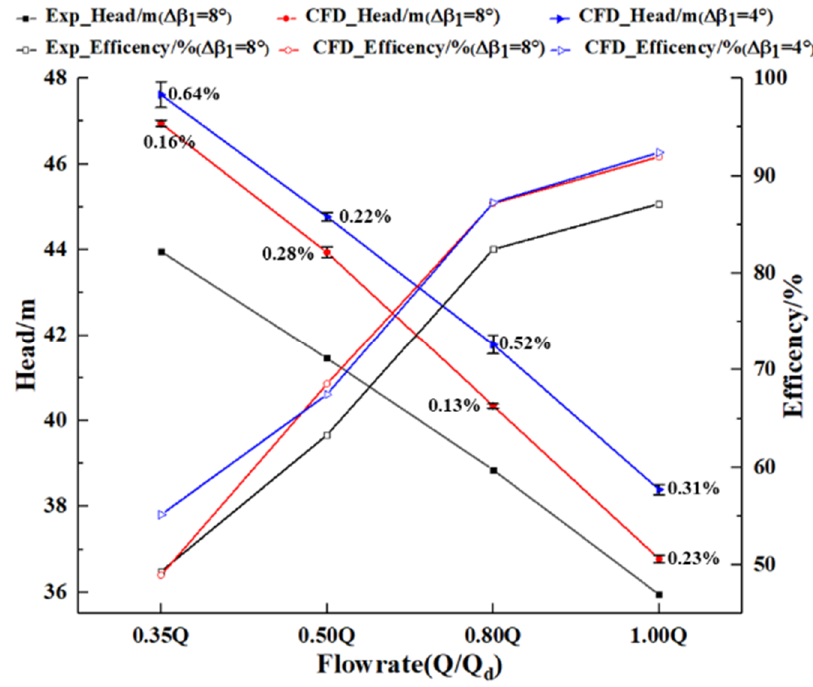
Figure 8. External characteristics curve of numerical method verification.